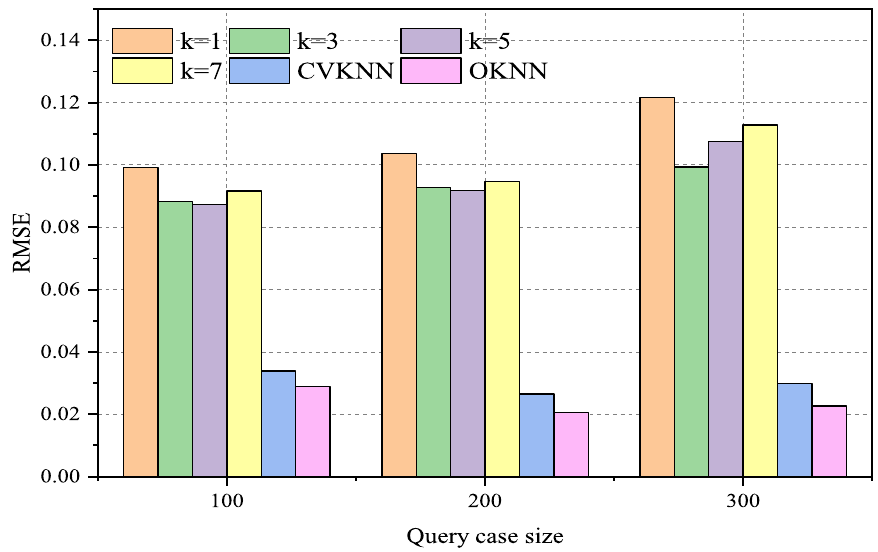
Figure 5. Prediction error for different methods.